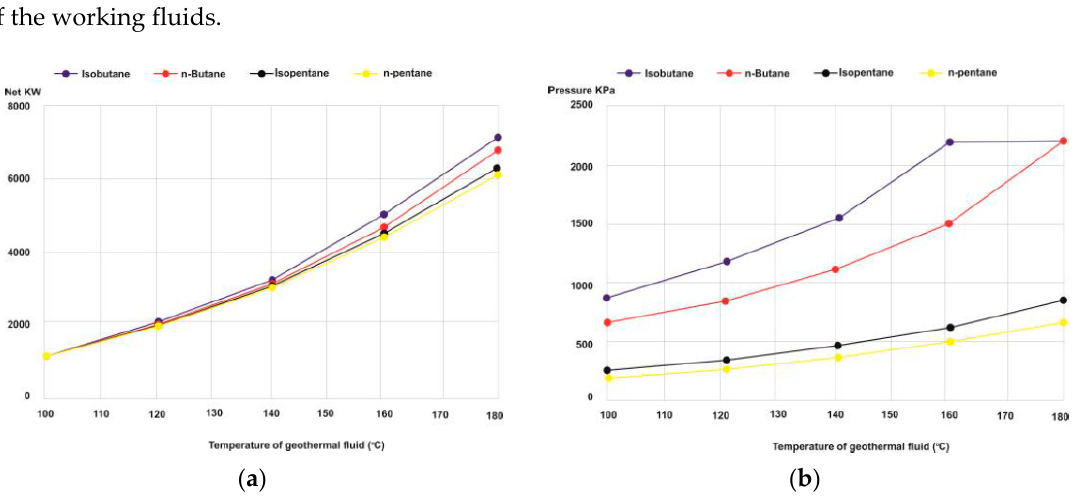
Figure 2. ( a ) Net power of the ORC according to the temperature of the geothermal fluid; ( b ) ORC pressure in Pre-heating—evaporator depending on the temperature of the geothermal